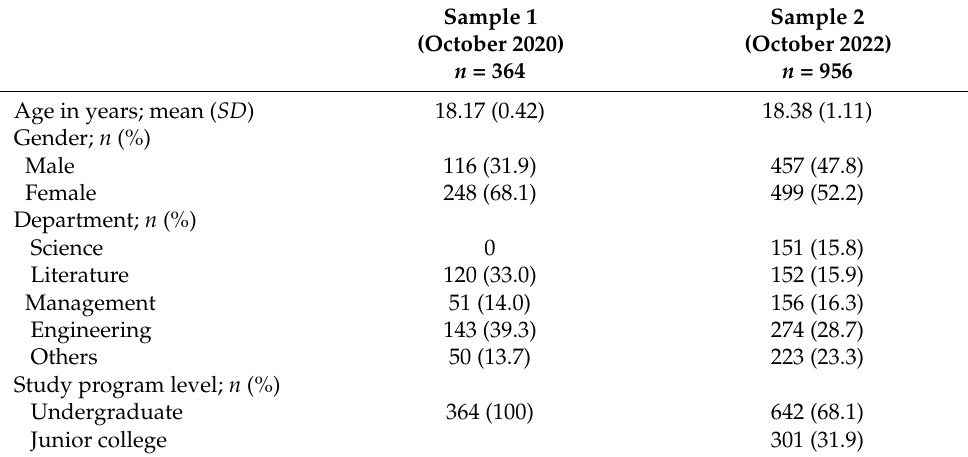
Table 1. Demographic characteristics of study